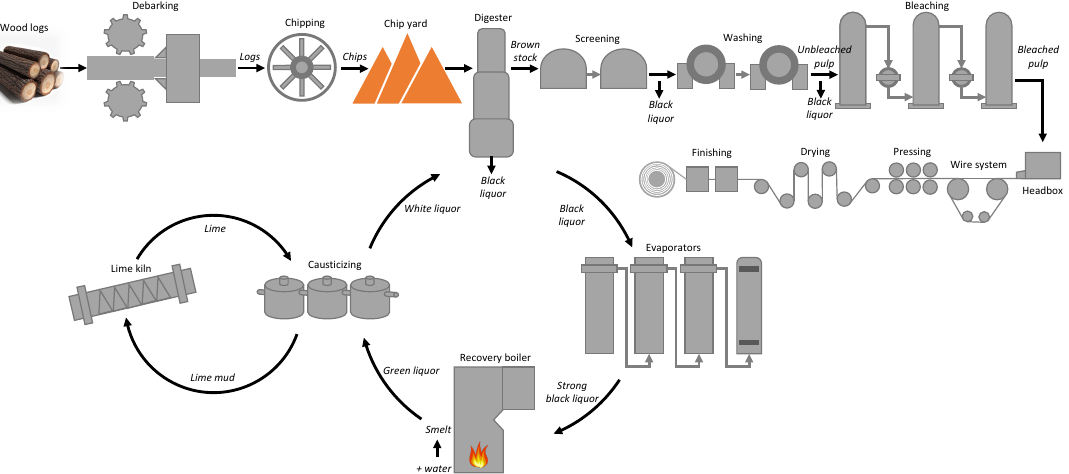
Figure 1. An overview of Kraft pulping process.